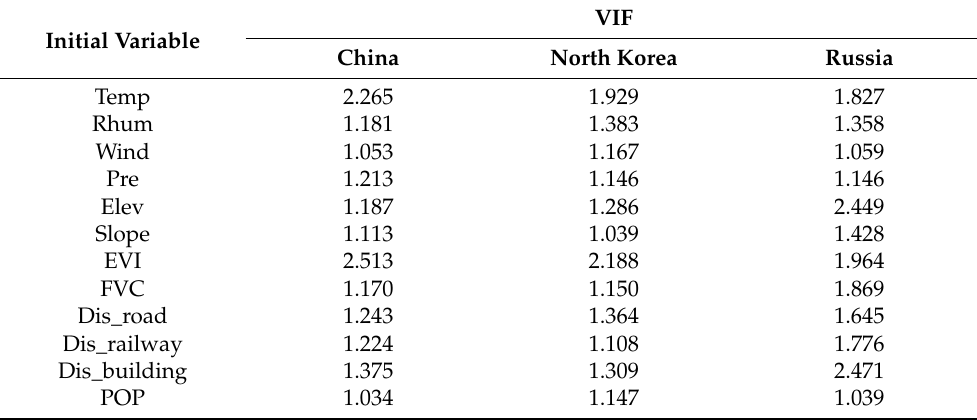
Table 3. The results of multicollinearity